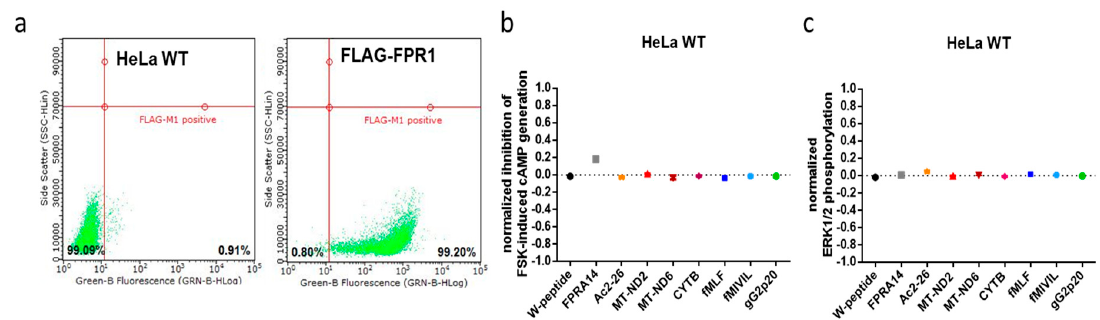
Figure A1. Agonist effects are specific for the FPR1 signaling axis. Parental HeLa cells were subjected to the assays analyzing ( a ) internalization, ( b ) cAMP formation, and ( c ) MAPKinase activation, at agonist concentrations eliciting the respective E max response. ( a ) A representative result, ( b ), ( c ) mean response ± SEM, n 6.